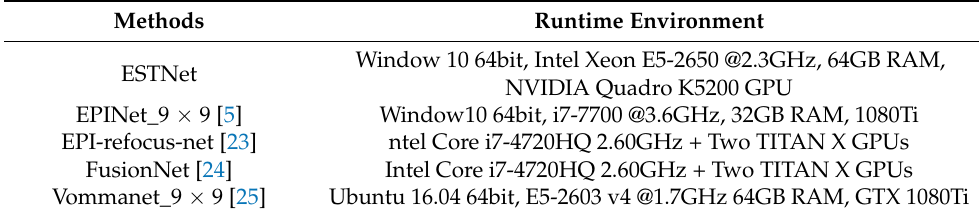
Table 6. Runtime environment of current popular neural networks.